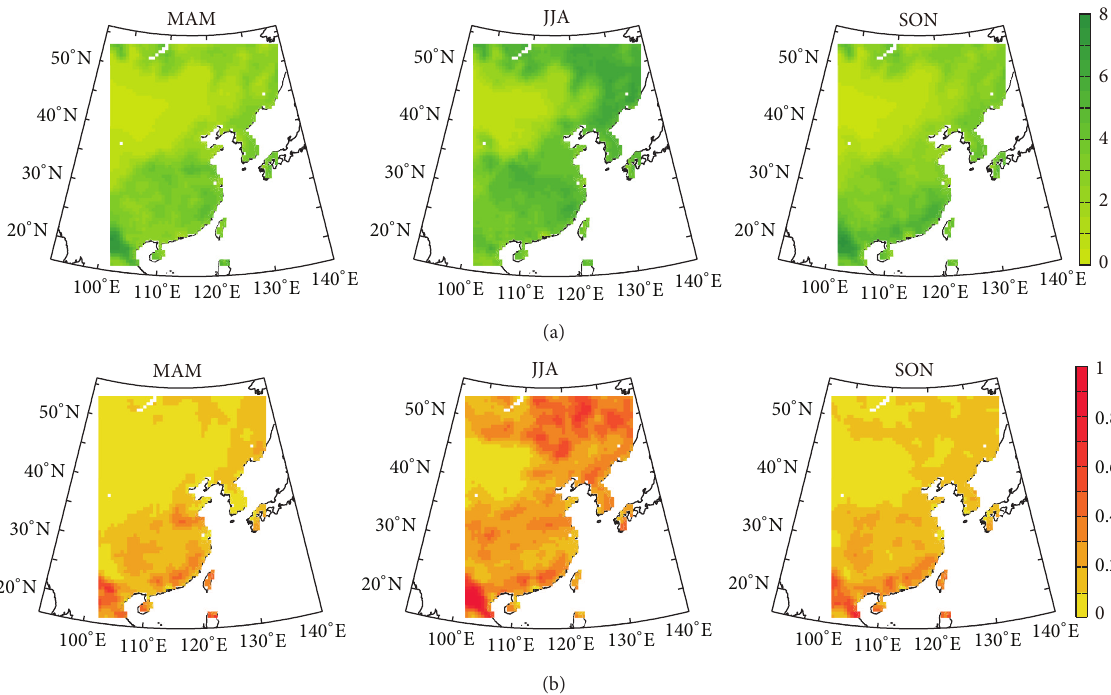
Figure 2: Mean (a) and standard deviation (b) of leaf area index (LAI) from 2002 to 2009 for spring (March to May; MAM), summer (June to August; JJA), and autumn (September to November;